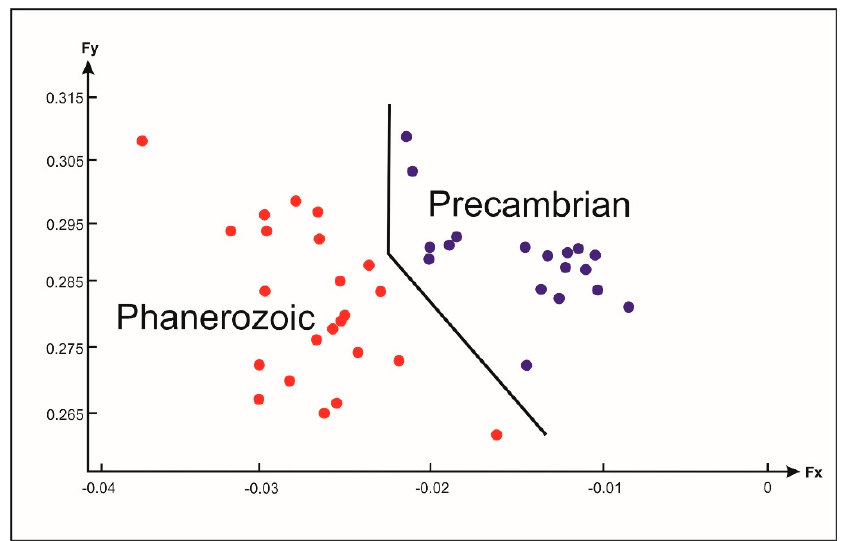
Figure 4. Location of median values of compositions of basic rocks from different Phanerozoic (red dots) and Precambrian (blue dots) rock assemblages [9] on diagram Fx − Fy, where: Fx = − 0.1SiO 2 − 0.82TiO 2 − 0.11Al 2 O 3 + 0.34FeO + 0.06MgO + 0.03CaO − 0.28Na 2 O + 0.32K 2 O; Fy = 0.45SiO 2 − 0.28TiO 2 + 0.21Al 2 O 3 + 0.22FeO − 0.06MgO + 0.24CaO − 0.27Na 2 O − 0.75K 2 O.